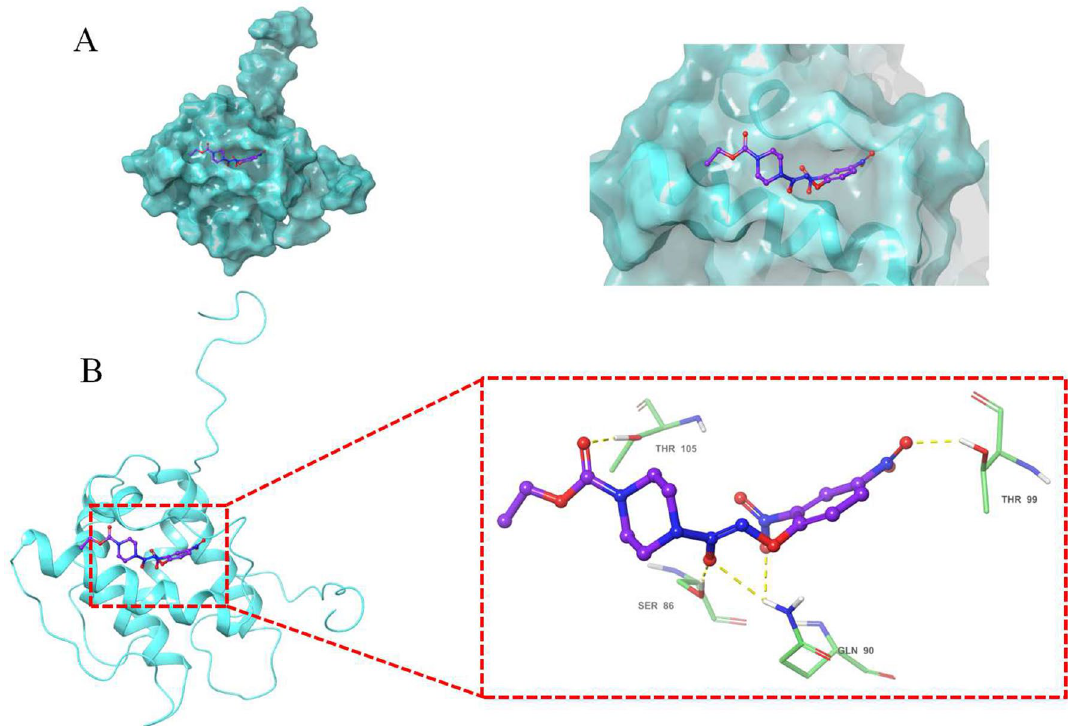
Figure 5. The interaction between JS-K and TAGLN were displayed using Autodock. ( A ) The substrate binding surface, ( B ) Interactions of JS-K with active site amino acids of TAGLN (AutoDock Vina, 1.1.2, https:// sourc eforge. net/ proje cts /AutoDock Vina